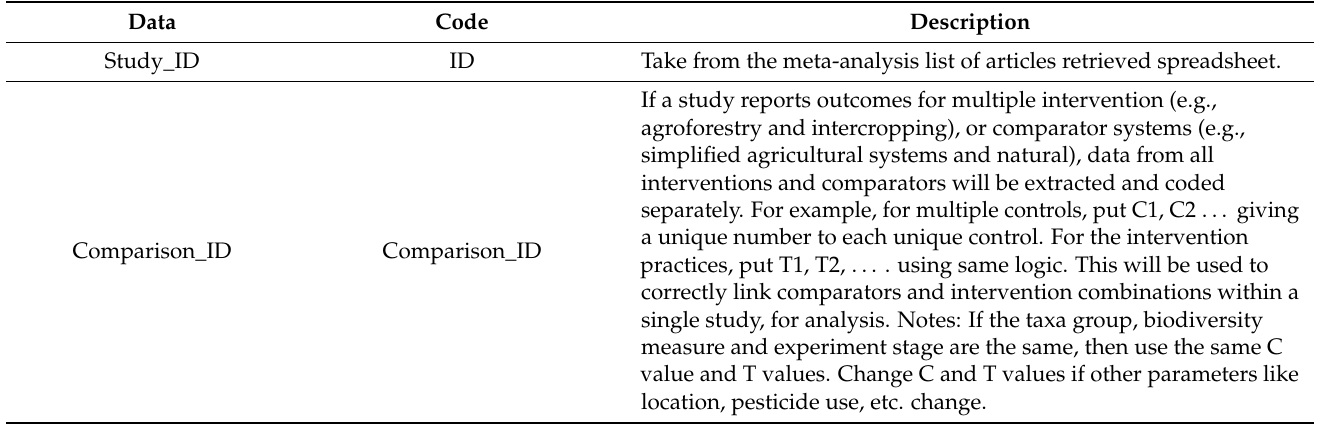
Table A2. Extraction sheet. Includes the quantitative and qualitative meta-data to be extracted along, with a clear explanation of how to record and code the data for each